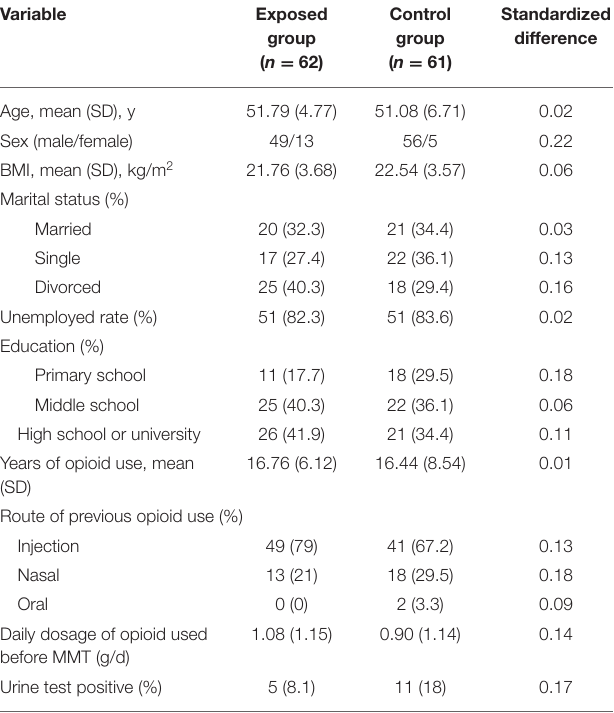
TABLE 2 | Characteristics at baseline (PPS).